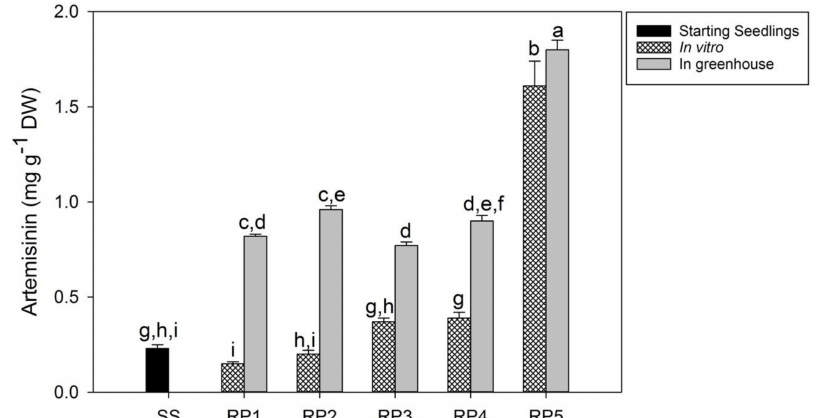
Figure 3. Artemisinin analysis of Artemisia annua in seedlings and regenerated plants (RPs). Data are expressed as mg g − 1 (DW) and are means ± standard deviation of two independent replicates (n = 2). Data were submitted to one-way analysis of variance (ANOVA). Differences among groups were detected using multiple comparison procedures (Tukey test) and indicated with different letters.